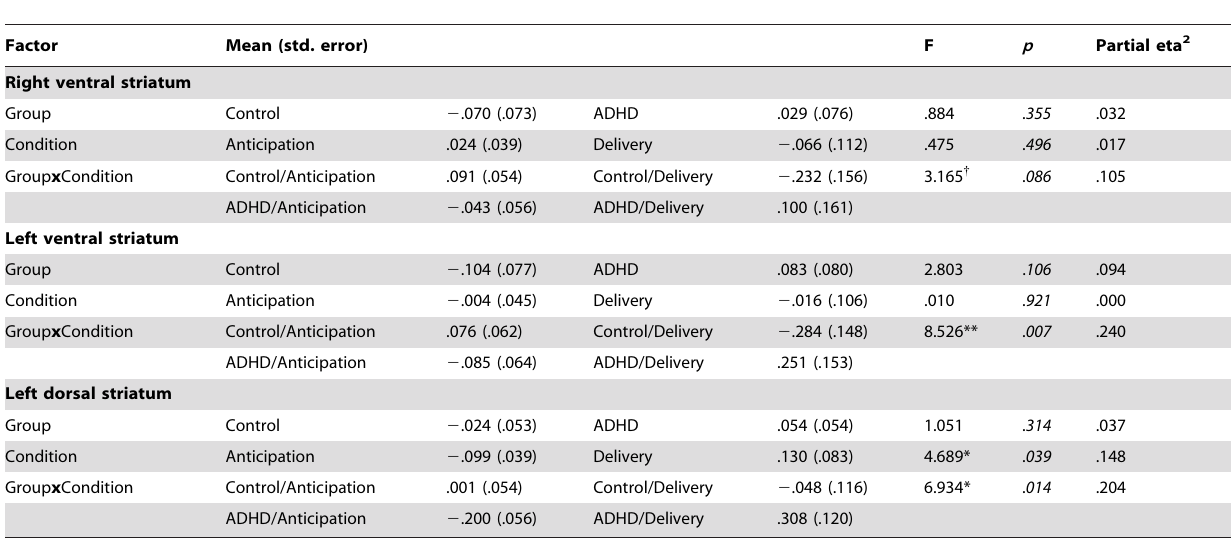
Table 2. The interaction effects of the group (control vs. ADHD) and condition (reward anticipation vs. reward delivery).